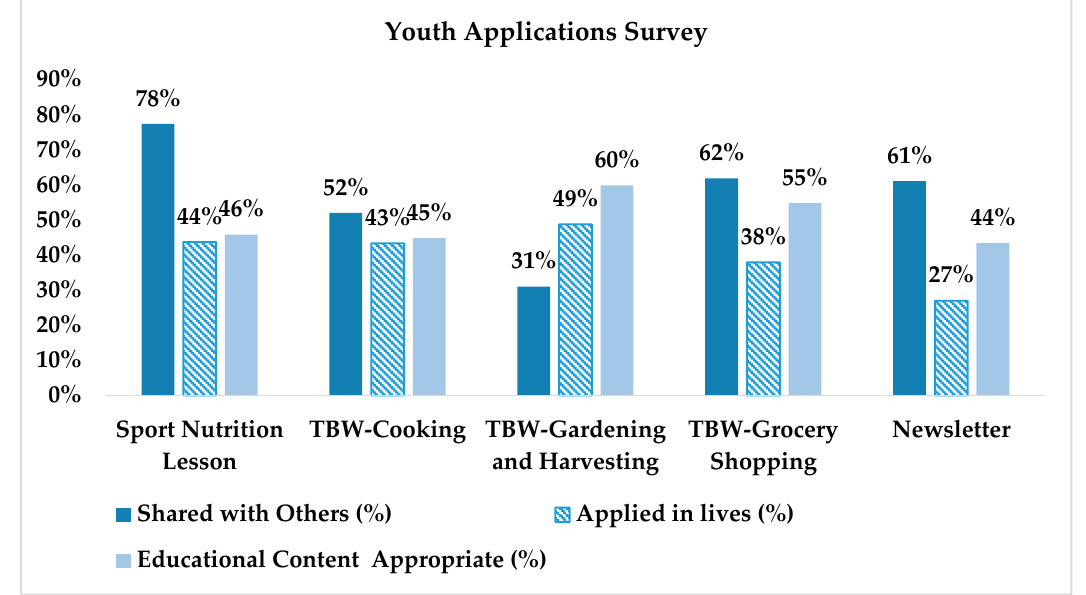
Figure 3. Youth rating of the WAVE educational components and learning outcomes. TBW: team- building workshop.